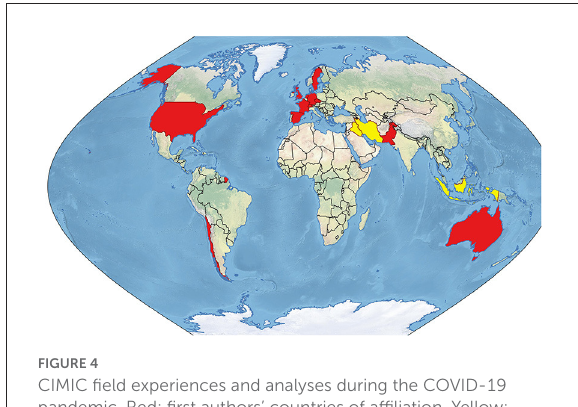
crisis worldwide: (1) minimal technical military support, (2) blended civil-military responses, and (3) military-led responses (47). An interesting example for enhancing crisis management